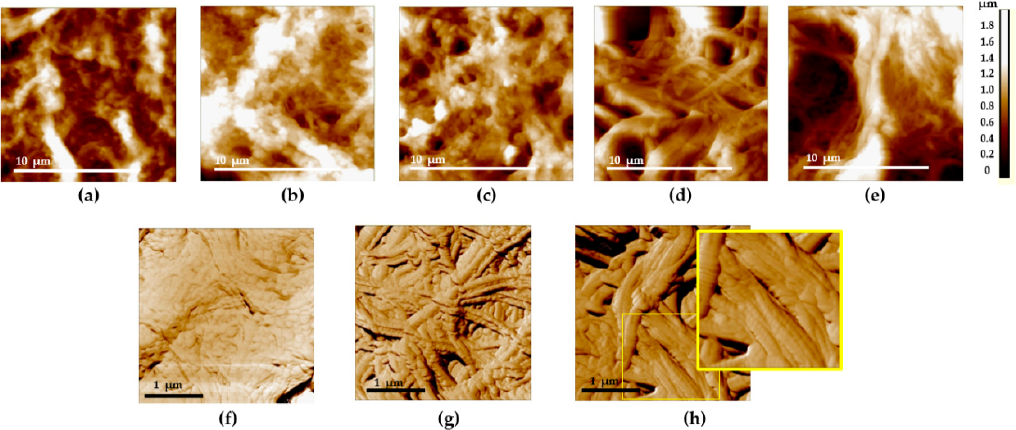
Figure 4. Typical AFM images of the bladder mucosa in the studied patients’ groups: ( a , f ) “normal” group; ( b ) “chronic cystitis” group; ( c , g ) “Grade 2 radiation cystitis” group; ( d ) “Grade 3 radiation cystitis” group; ( e , h ) “Grade 4 radiation cystitis” group. ( a – e ) 14 × 14 µm, topography: an increase in the deep ruptures’ area is seen from the left to the right. ( f – h ) 3×3 µm, phase: an increase in the area of denuded collagen fibrils is seen from the left to the right: full coverage of collagen fibrils with the amorphous substance ( f ), collagen fibrils are partially ( g ) and completely ( h ) denuded with the discernible D-period (see the enlarged view of the ( h ) image indicated by the yellow rectangle).